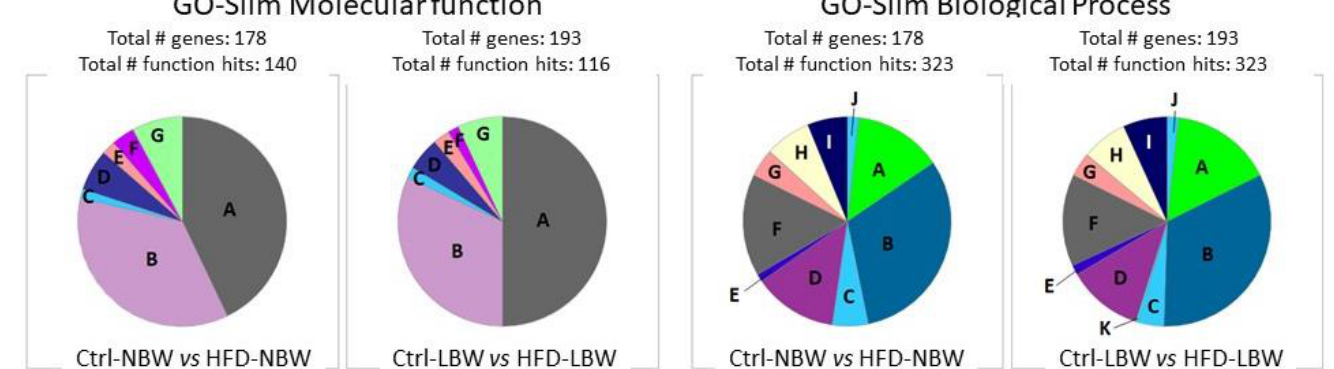
Figure 5. Functional classification of differentially abundant proteins identified in pigs comparing the effect of an HFD diet in NBW and LBW animals by Slim-GO analysis of the Molecular function and biological processes ontologies. (left hand) Molecular Function: A, binding; B, catalytic activity; C, molecular adaptor activity; D: molecular function regulator; E, molecular transducer activity; F: structural molecule activity; G, transporter activity. (right hand) Biological Process: A, biological regulation; B, cellular processes; C, developmental process; D, localization; E, locomotion; F, metabolic process; G, multicellular organismal process; H, response to stimuli; I, signaling; J, biological adhesion; K, growth. Table 3. Response of NBW and LBW animals to an HFD. Comparison between GO categories in NBW and LBW groups: Main categories from Panther have been selected and fold of enrichment indicated. Only main categories with the highest enrichment fold are shown.